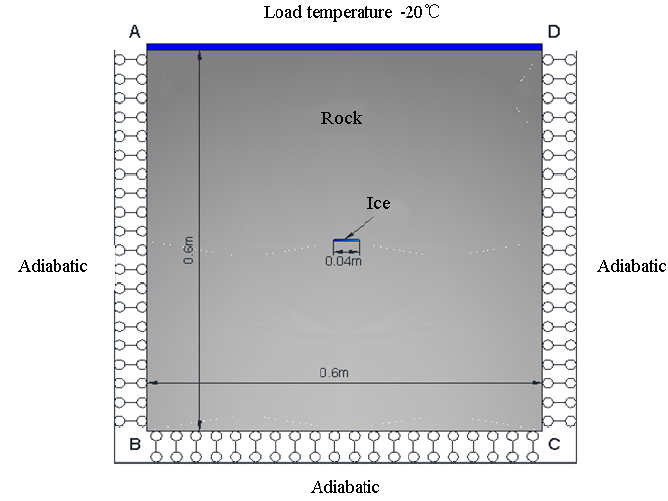
Figure 9. Dimensional drawing of the frost heave model. Table 2. Mechanical parameters of the rock and ice.